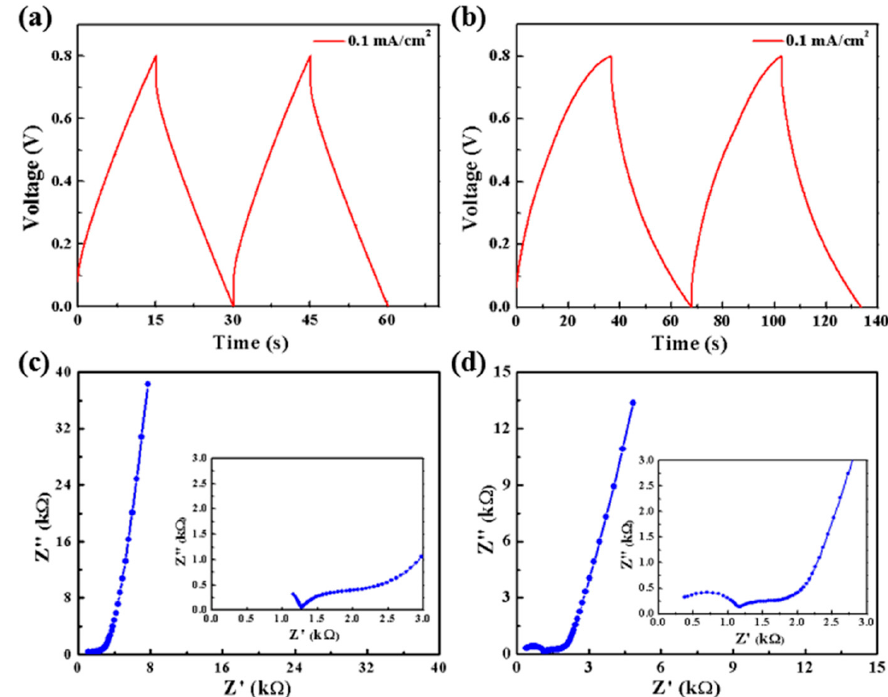
Figure 5. ( a , b ) GCD curves of carbon-MSC and carbon / CNT-MSC at a current density of 0.1 mA / cm 2 . ( c , d ) Electrochemical impedance spectroscopy (EIS) results of carbon-MSC and carbon / CNT-MSC with a frequency range from 0.01 to 100,000 Hz. Table 1. Performance comparison of carbon-based MSCs.